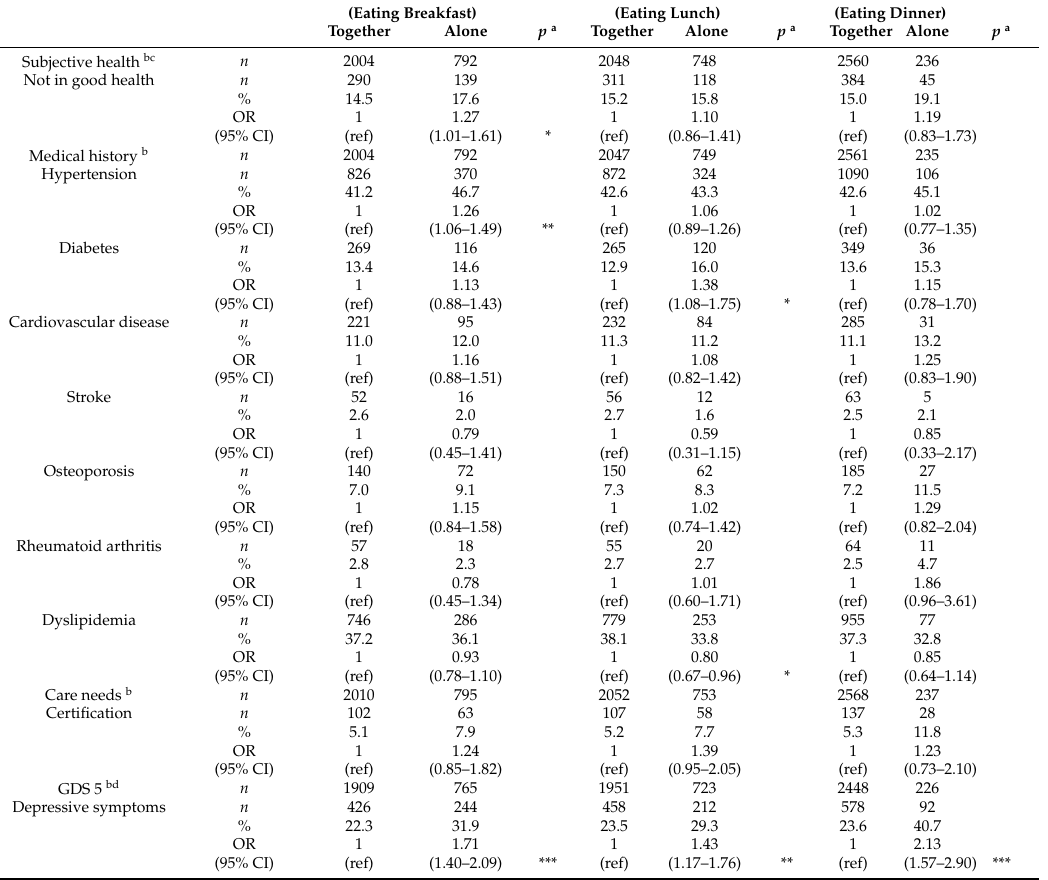
Table 2. Association of eating alone at each meal with subjective health, medical history, care needs, and depression ( n =